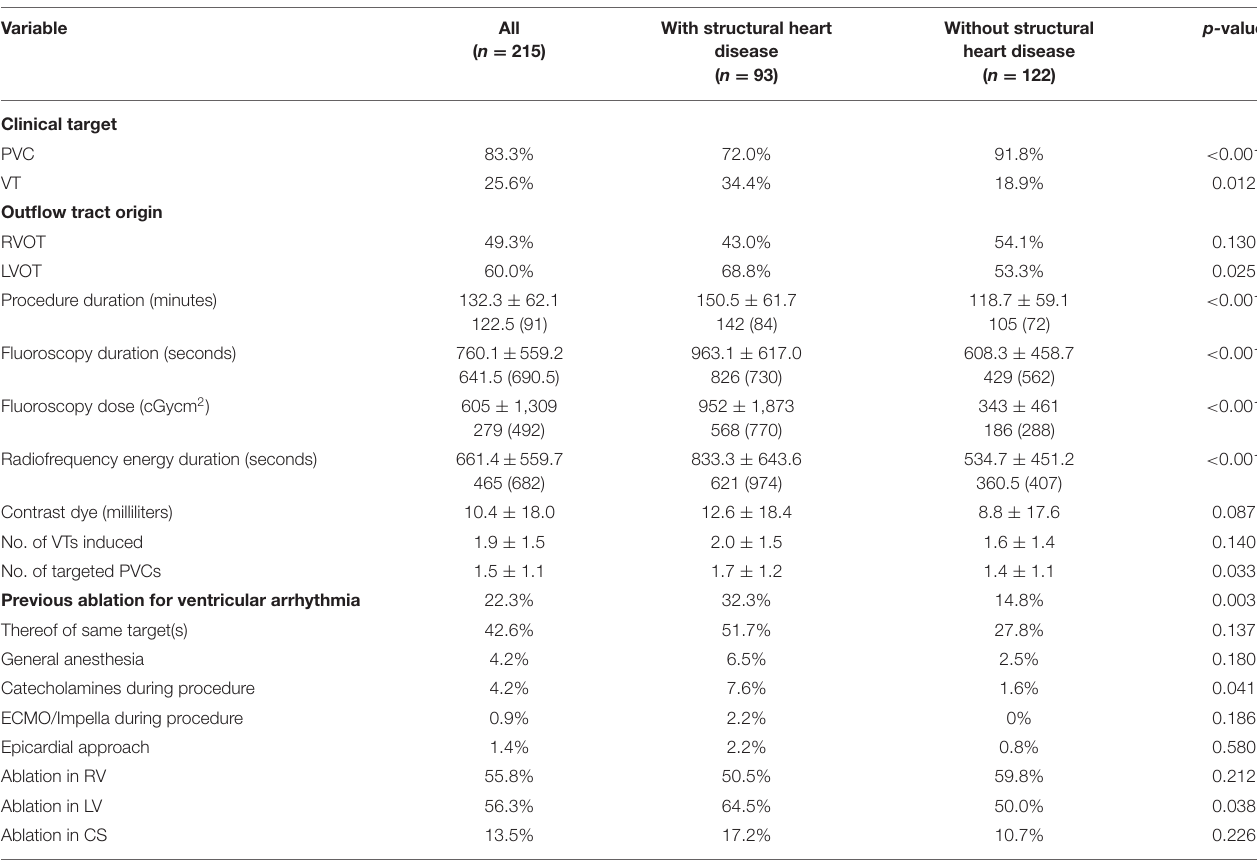
TABLE 2 | Procedural parameters of patients with outflow tract arrhythmias.